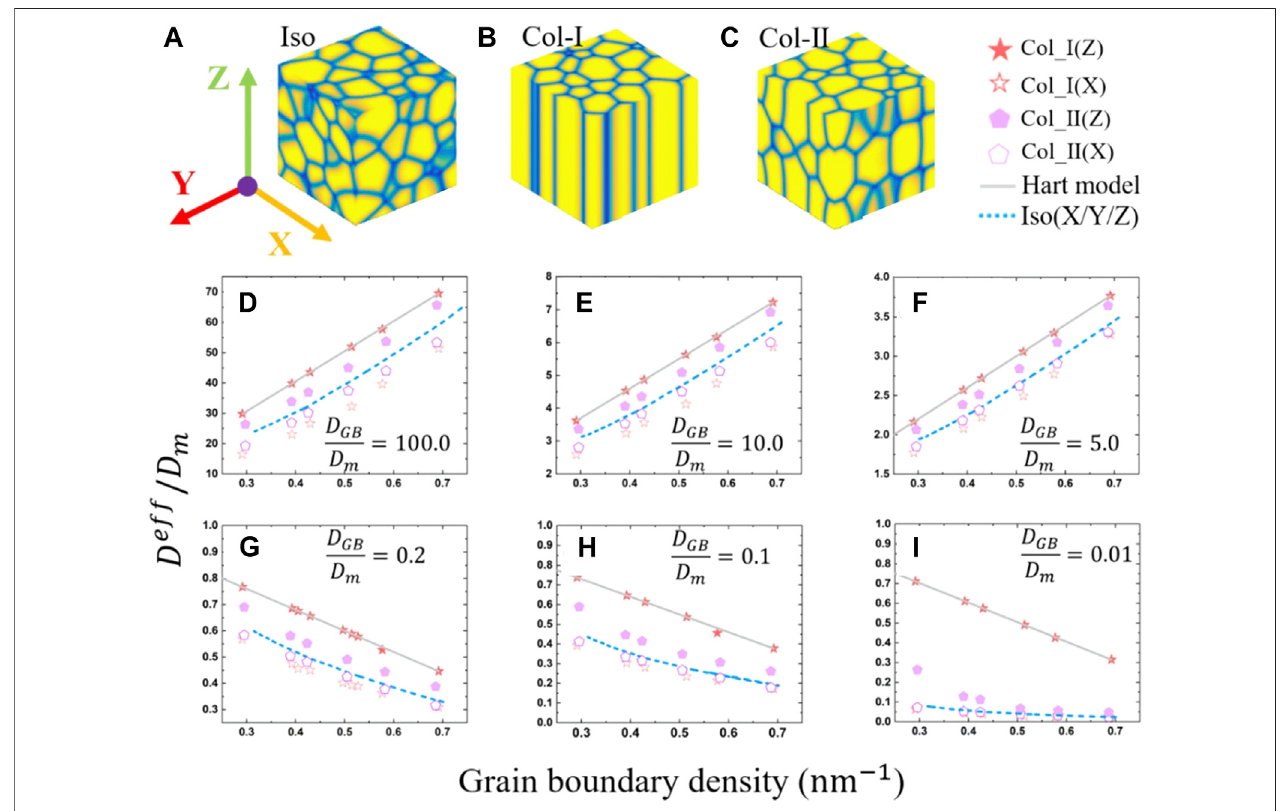
FIGURE4| Polycrystallinestructure ofthe (A) isometric crystal, (B) columnar-I crystal,and (C) columnar-II crystal.The calculated effective diffusioncoef fi cients for threedifferentpolycrystallinestructureswiththreediffusioncoef fi cientratios D GB / D m ofHaregreaterthan1.0 (D – F) andlessthan 1.0 (G – I) .Thesolidand hollowscatter pointsrepresenttheeffectivediffusioncoef fi cientparallelandperpendiculartothedirectionoftheelongatedgrainsofthecolumnarcrystals.Thegraysolidlinesrepresent the predicted effective diffusion coef fi cient as a function of the grain boundary density along the elongated orientations of structure Col-I by Hart ’ s model and the blue dotted lines represent that predicted by the HS ’ s model for the isometric